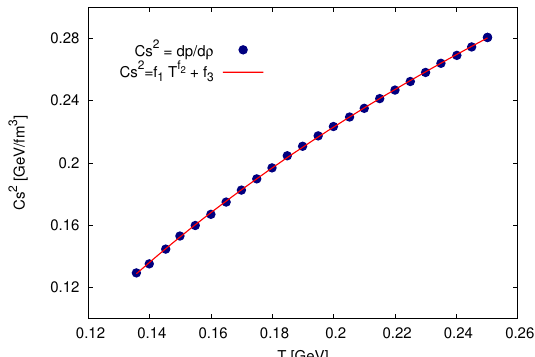
Figure 13. Speed of sound squared c 2 s is given in dependence on the temperature T . The symbols are the lattice QCD calculations [22]. The solid curve represents Equation